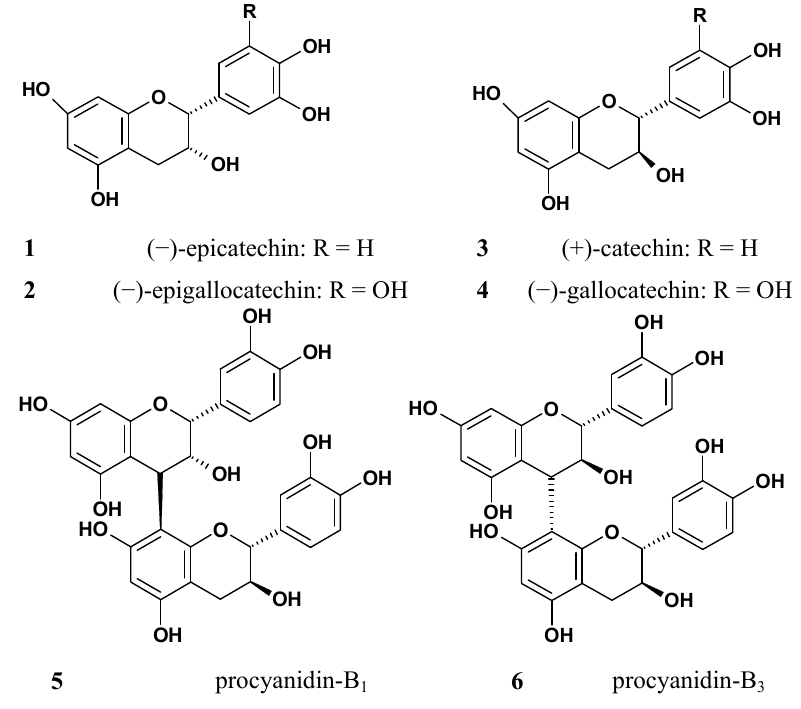
Figure 2. Structures of the catechins and procyanidins identified in EGb761.